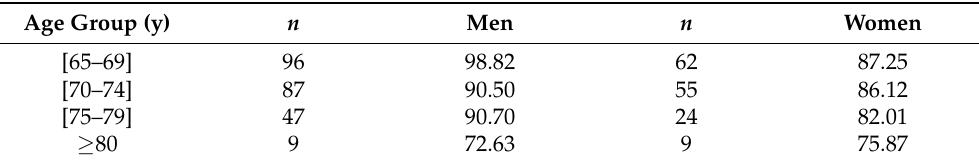
Table 1. Gait speed * cut-scores for defining slower gait speed for the Motoric Cognitive Risk (MCR)